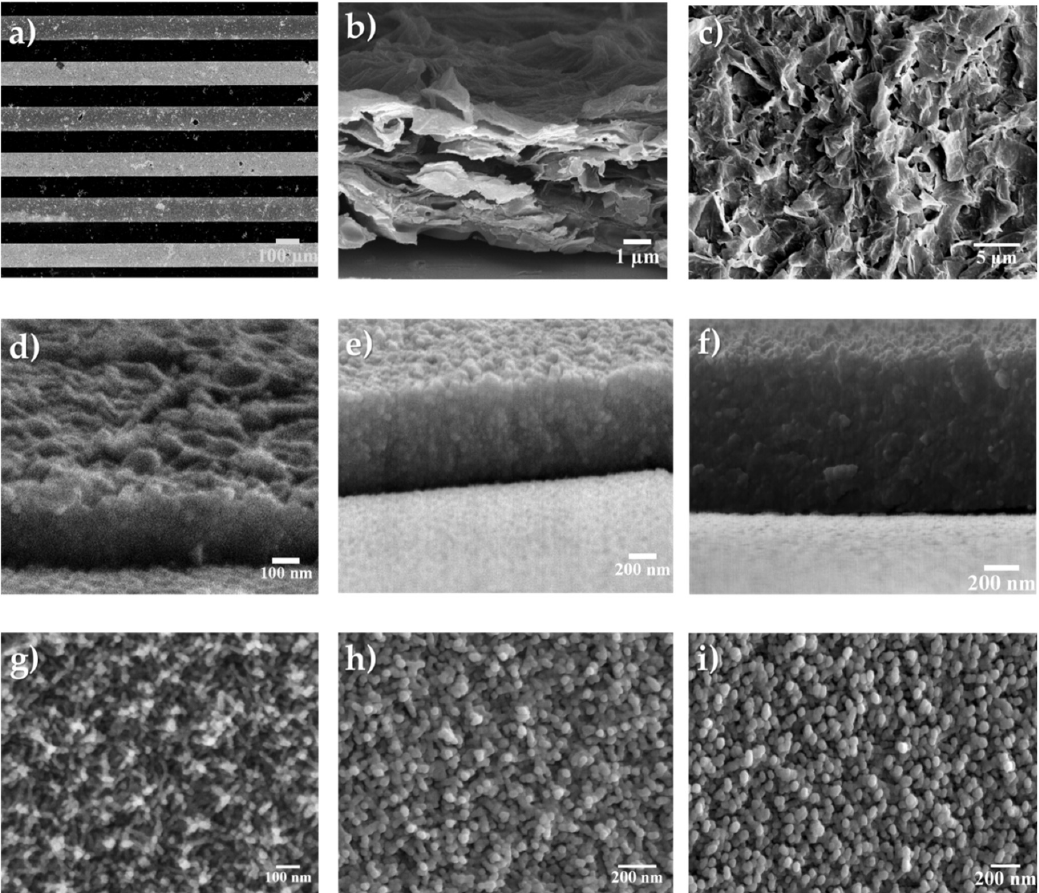
Figure 3. ( a ) SEM micrograph of the interdigitated rGO and MnO x microelectrodes; ( b ) cross sectional view and ( c ) top view of the rGO coated microelectrodes; ( d – f ) cross sectional view of the MnO x microelectrodes deposited at 0.6, 0.9 and 1.2 C cm −2 , respectively; ( g – i ) top-view of the MnO x microelectrodes deposited at 0.6, 0.9 and 1.2 C cm −2 , respectively.